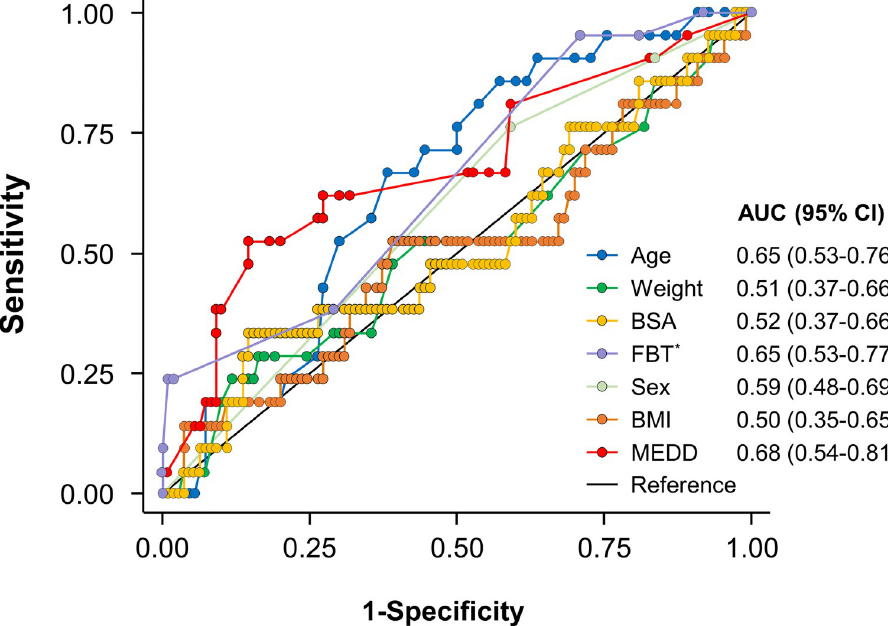
Fig 2. Receiver operating characteristic (ROC) curves for prediction of tolerability of high-dose fentanyl buccal tablet (FBT). BMI, body mass index; BSA, body surface area; MEDD, oral morphine equivalent daily dose; FBT, frequency of fentanyl buccal tablets required